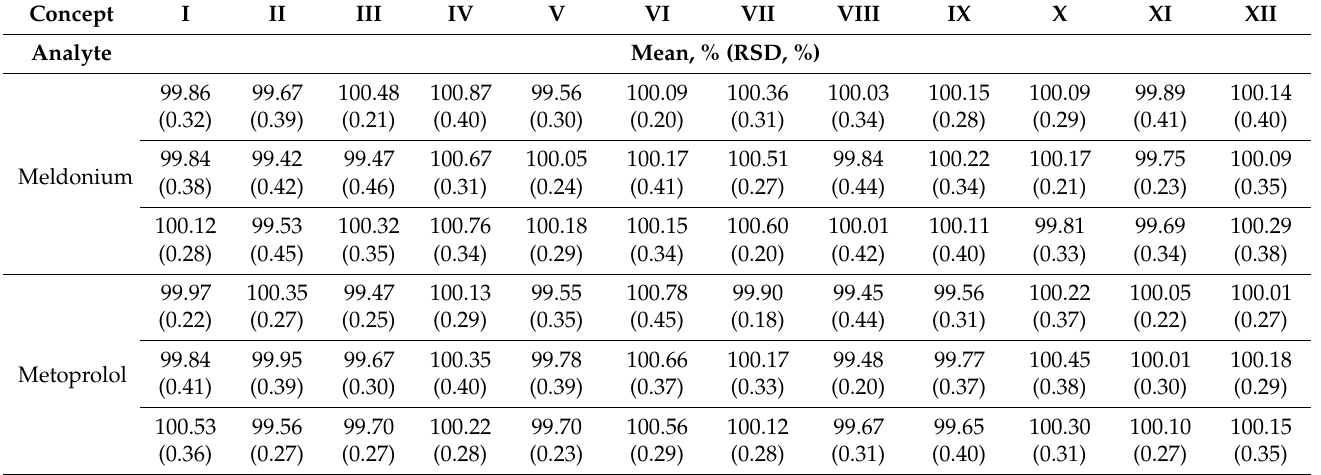
Table 2. Intra-day accuracy and precision results.